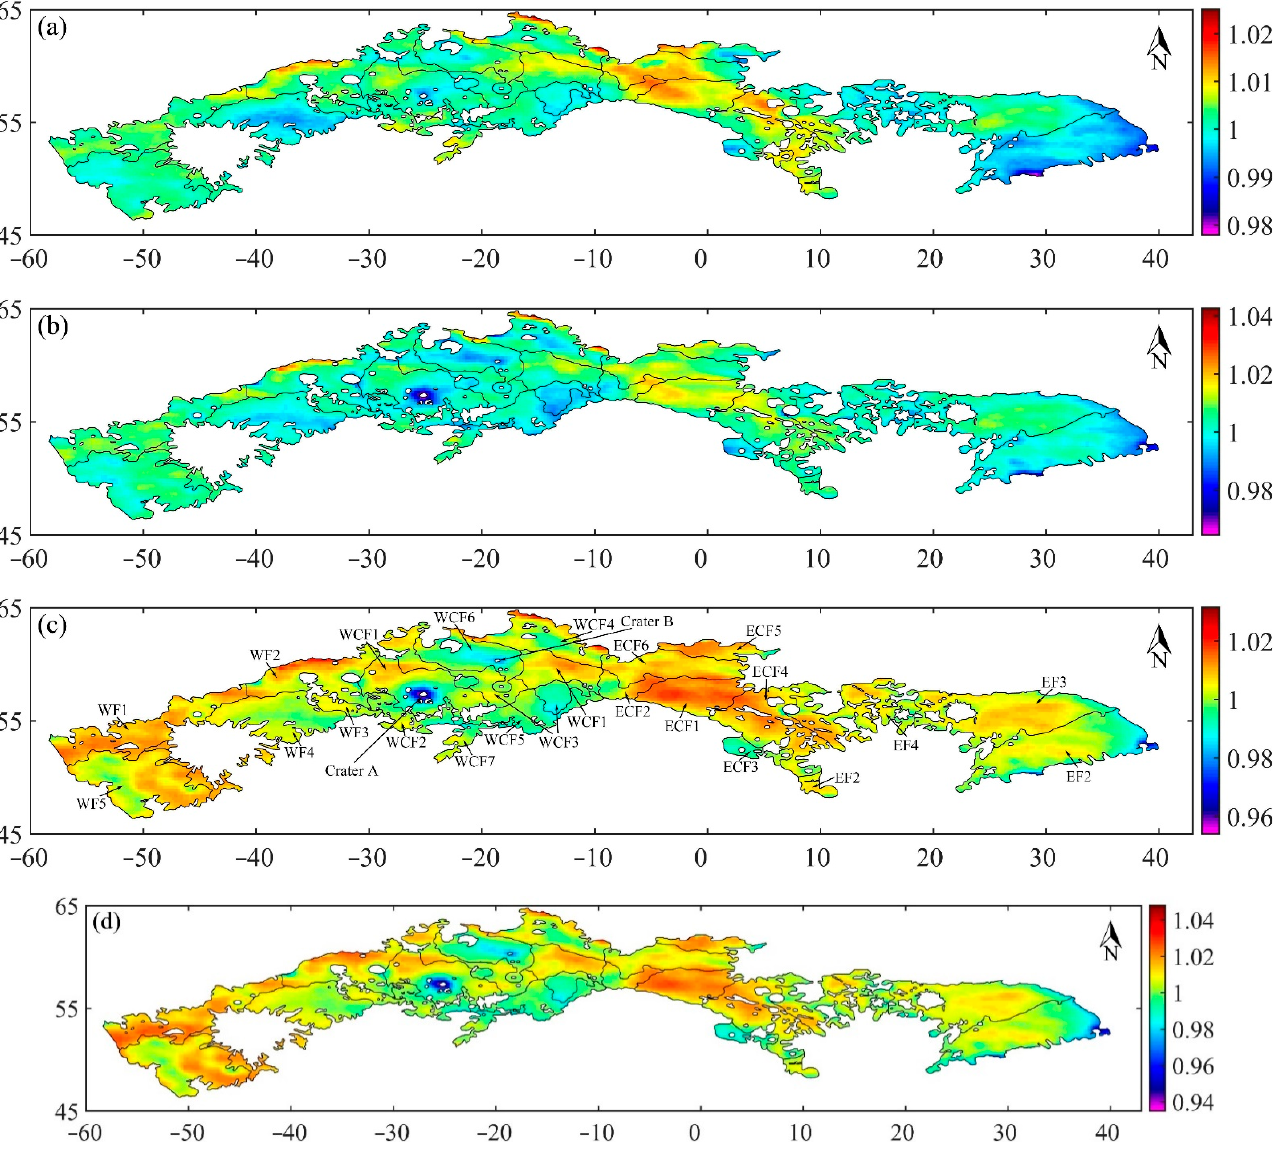
Figure 5. Normalized TB maps of Mare Frigoris at night: ( a ) 3.0 GHz, ( b ) 7.8 GHz, ( c ) 19.35 GHz, and ( d ) 37 GHz (equidistant cylindrical projection). The black lines are the geologic boundaries of Mare Frigoris mapped by Kramer et al. [2]. Crater A and Crater B are two craters with TB anomalies, as discussed in Sections 3.2.2 and 4.2.1.